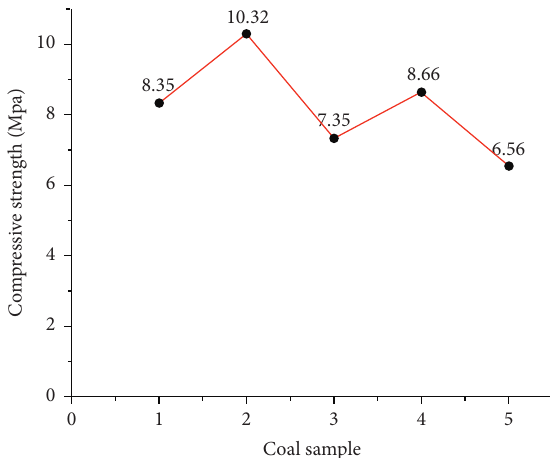
Figure 11: Uniaxial compressive strength of different coal samples.